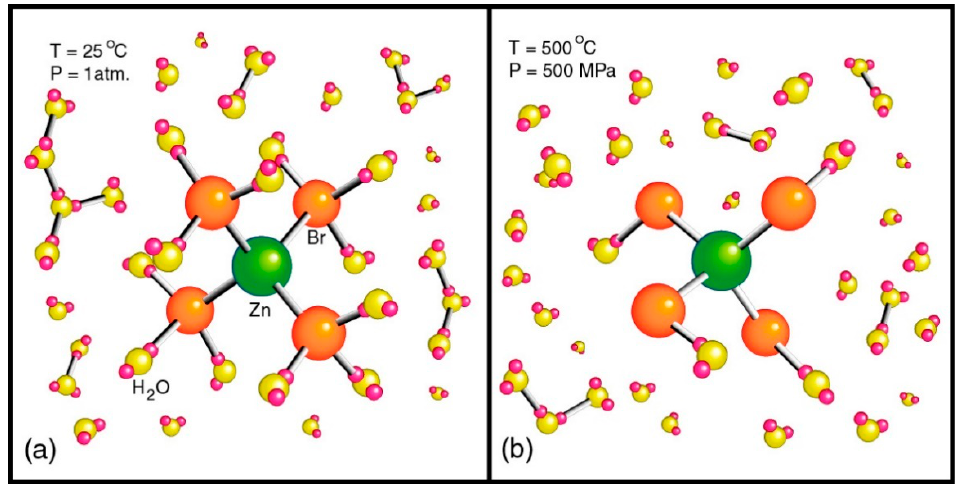
Figure 5. ( a ) This hydration shell surrounding a ZnBr 42 − ion is typical of the structures we found for the hydrated molecules of a range of compositions. ( b ) At 500 °C and 500 MPa, the sample density, although above the critical point, is only slightly less than the liquid phase. Some of the outermost H 2 O molecules become detached from of ZnBr 42 − ion. Other compounds in solution such as rare-earth bromides have very different complex configurations and responses to temperature [7].